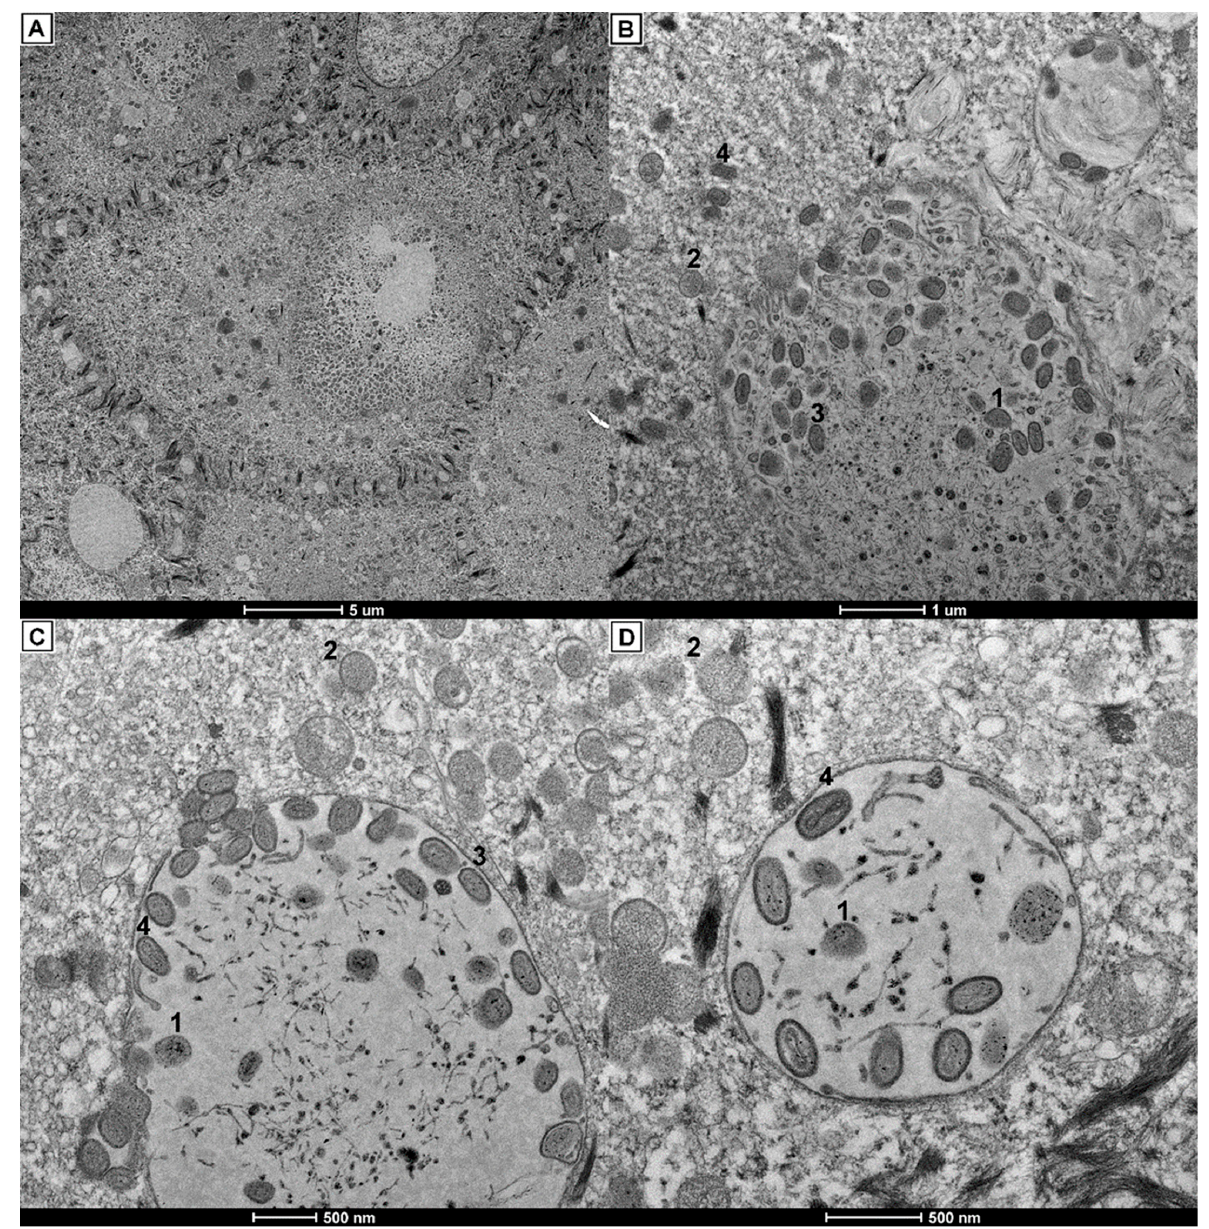
Figure 7. Electron micrographs showing poxvirus particles from the epithelial lesions in the beak. ( A ) Epithelial cells with medium to large intracytoplasmic inclusion bodies and vesicles containing granular material. ( B ) Viral particles in the periphery of the inclusion bodies containing all the poxvirus particle stages. ( C ) Mature viral particles at the periphery of the inclusion body membrane and protruding to the cytoplasm. Cytoplasmic viral particles with less dense nucleoids. ( D ) Enclosed inclusion body with incompletes, intermediates, and mature-form viral particles. Filaments and granules dispersed in the central part. Non-membrane-bound virus particles free in cytoplasm. Viral particles stages: incomplete form (1), spheric form (2), intermediate forms (3), and mature form